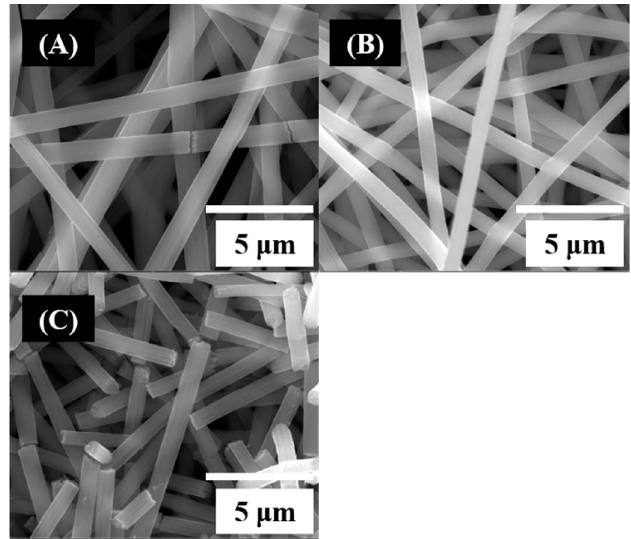
Figure 2. Field emission scanning electron microscope (FE-SEM) images of electrospinning TiO 2 / ZnO nanofibers: ( A ) 12 kV, ( B ) 15 kV, and ( C ) 18 kV.